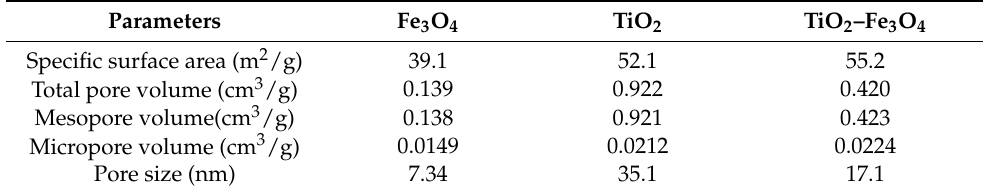
Table 1. Characteristics of Fe 3 O 4 , TiO 2 and TiO 2 –Fe 3 O 4